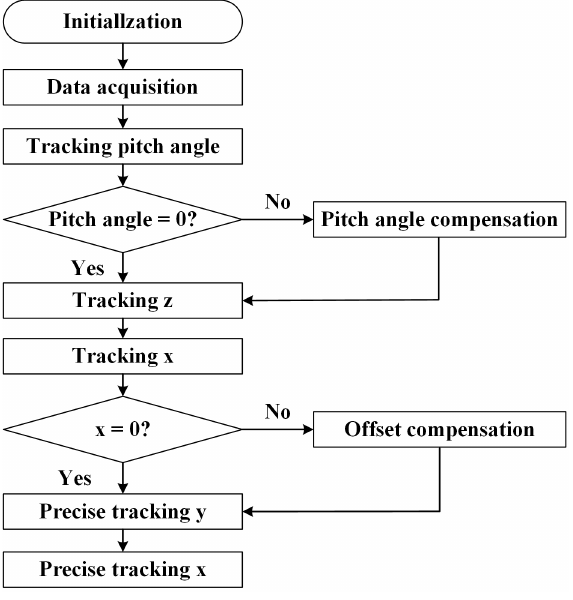
Figure 4. Block diagram of the 4-D tracking